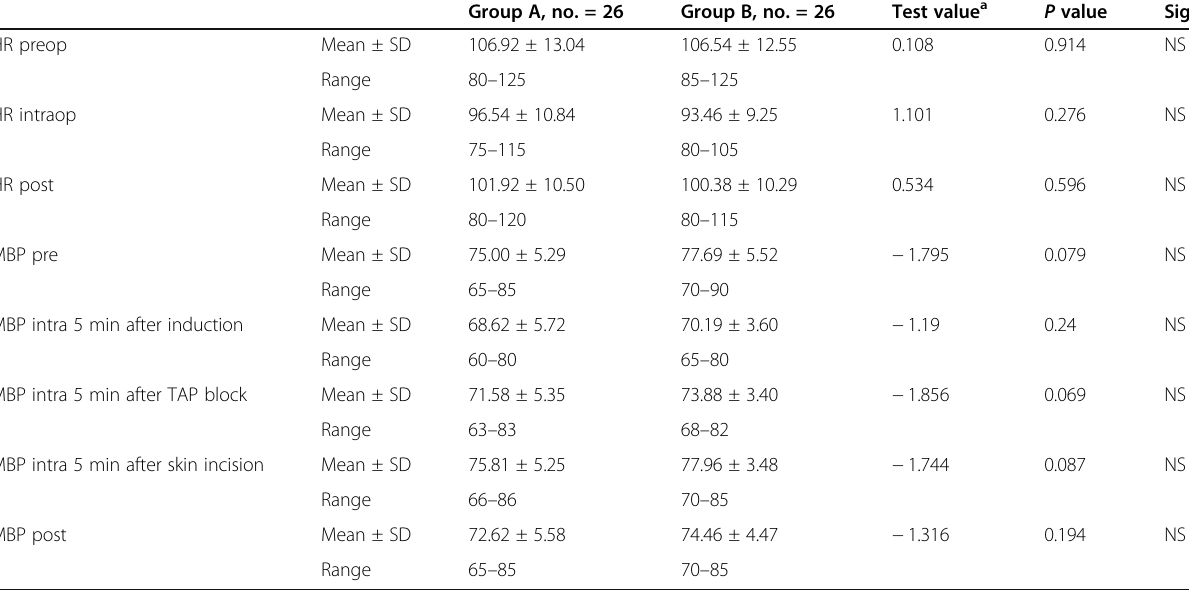
Table 3 Comparison between the two groups regarding heart rate and MBP preoperative, intraoperative, and postoperative Group A, no. = 26